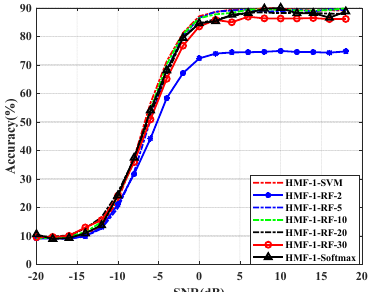
Table 1. Overall comparison of HMF-I and HMF.